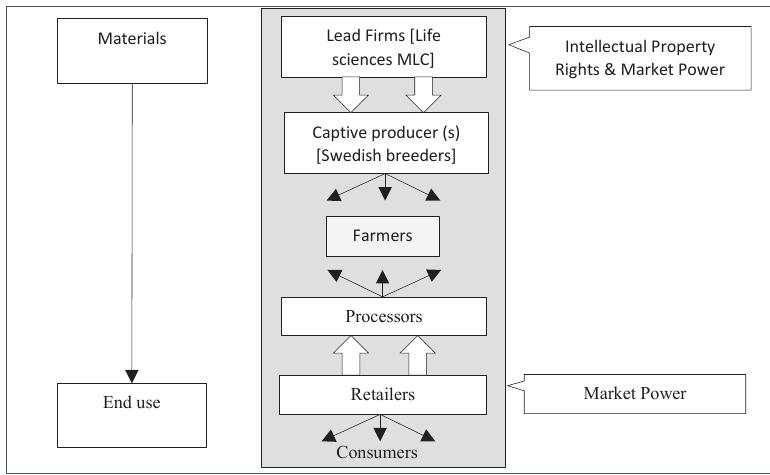
Fig. 1. Illustration of seed value chain: Captive